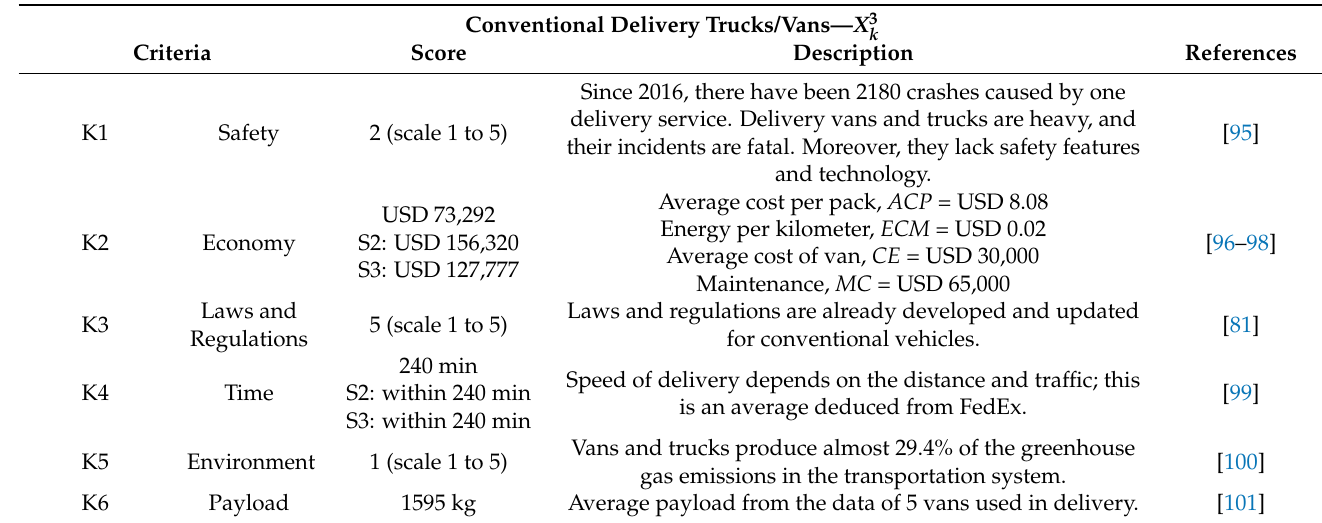
Table 4. Delivery vehicle scores in the case of S1 (unless otherwise